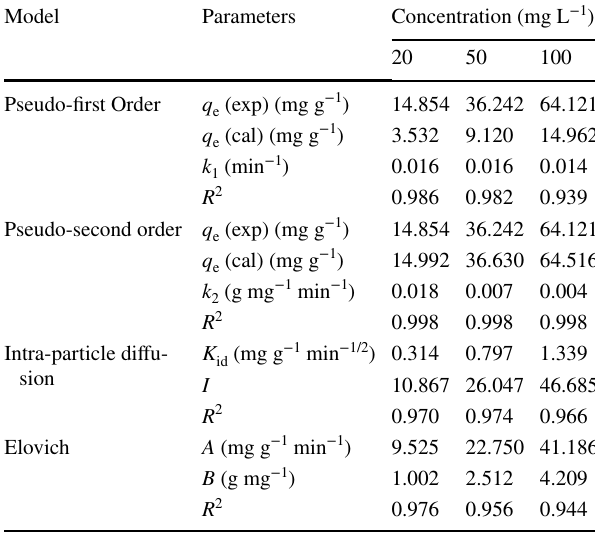
Table 2 Kinetics parameters for the adsorption of crystal violet dye on